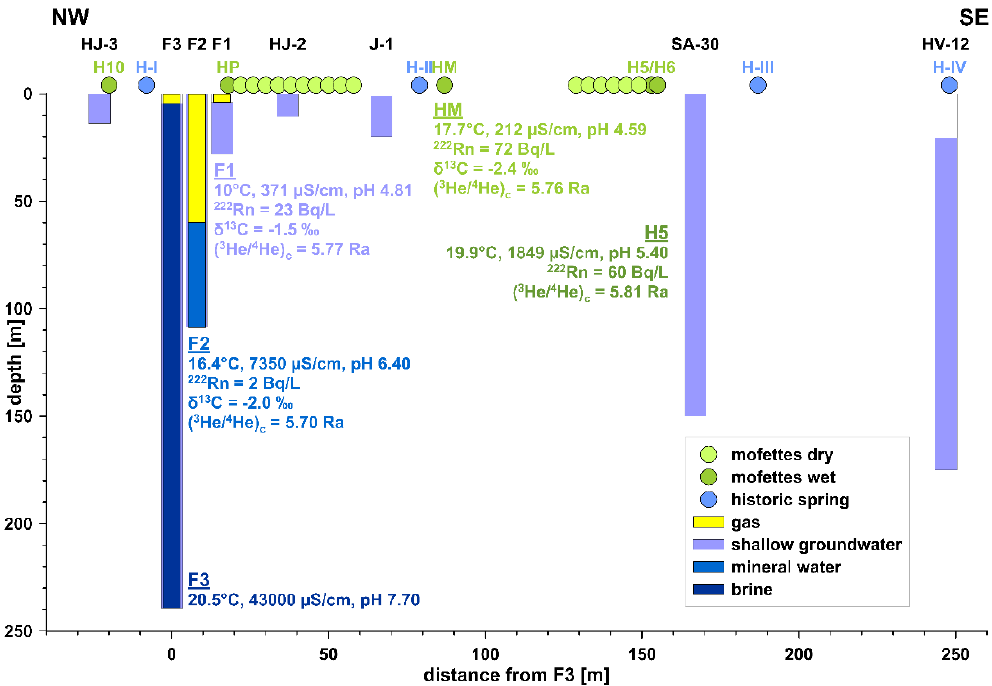
Figure 6. Hydrogeological inventory of the Hartoušov mofette field. Shown are fluid properties of wells and mofettes (site IDs are given at the top of the figure) along a NW–SE profile. The locations of the wells and mofettes are shown in Figure 3 (same IDs). Values are given for gas and water samples collected on 3/4 September 2019. Carbon isotope values are given in δ 13 C CO2 vs. V-PDB (‰).